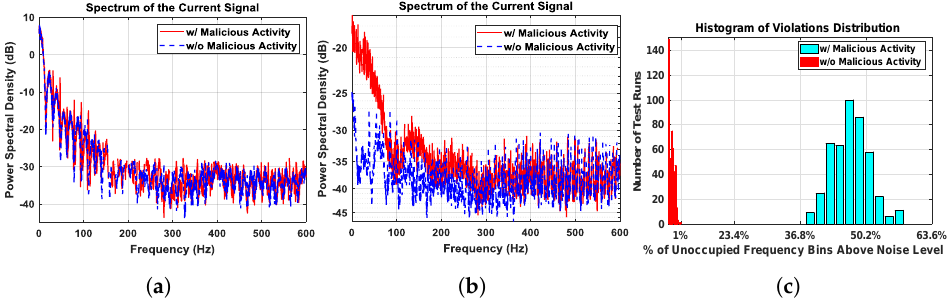
Figure 13. ( a ) Residual spectrum of random WiFi activity signatures with and without malicious activity are identical; ( b ) residual spectrum of Periodic WiFi activity clearly reveals that there is a significant difference; ( c ) histogram of number of spectrum violations for 1000 residual spectra out of which 500 had malicious activity with minimum 36.97% of spectrum violation, while without malicious activity experiments spectra with maximum 0.95% of spectrum violation as seen in Table 3.